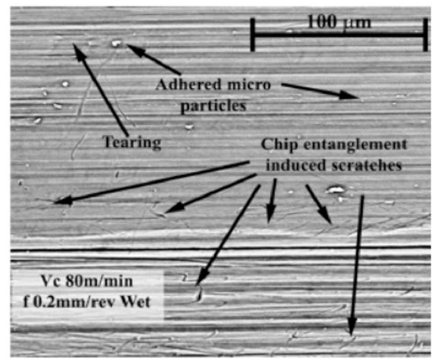
Figure 4. Main surface defects after 8 min of turning when adopting the wet, dry, and cryogenic cooling strategies: ( a , d ) material side flow, double feed marks, long grooves, and micro-particles adhered on the machined surface; ( b , e ) wider adhered chip fragments and BUE are a(cid:308)ached to the machined surfaces; ( c , f ) the wavy surface topography along the cu(cid:308)ing speed direction and the jagged feed mark peak [107] (Reprinted with permission from [107]. Copyright 2017, Elsevier).